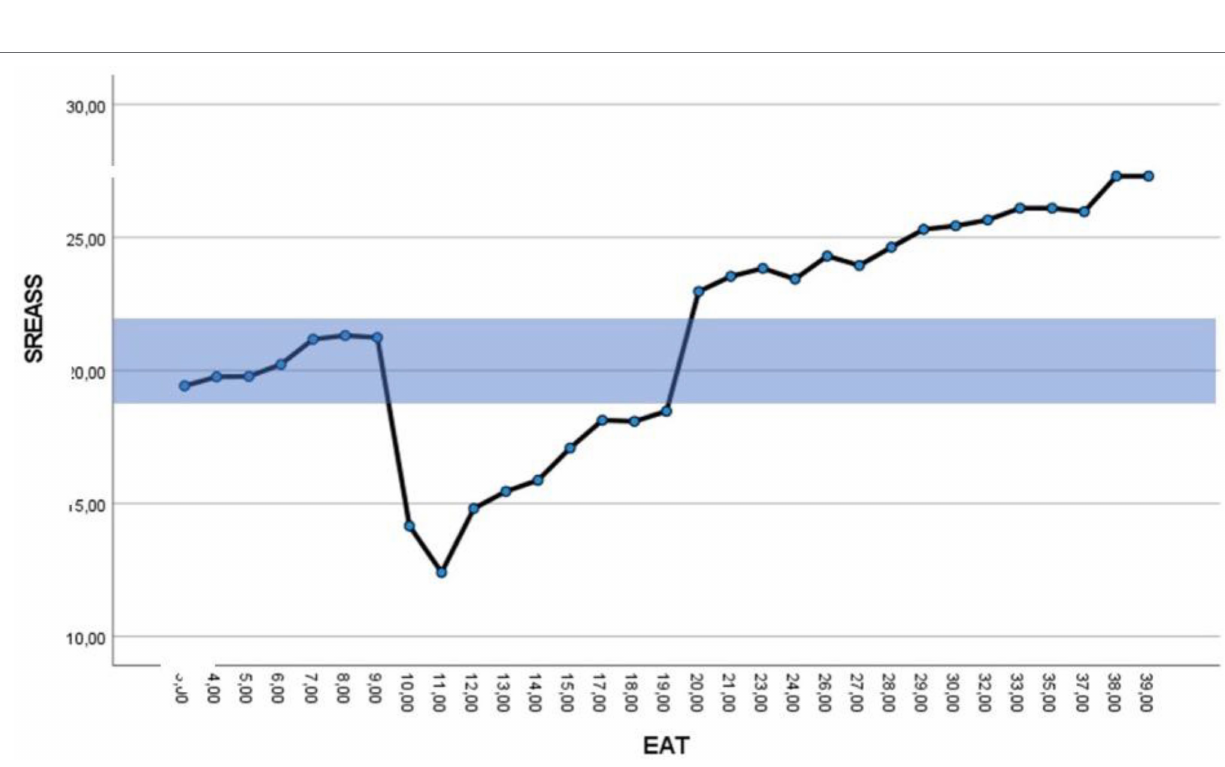
FIGURE 2 | Plot of the interaction between Eating Attitudes Test (EAT) and Self-Regulatory Eating Attitude in Sports Scale (SREASS) scores. X-axis refers to EAT scores and the Y-axis refers to SREASS